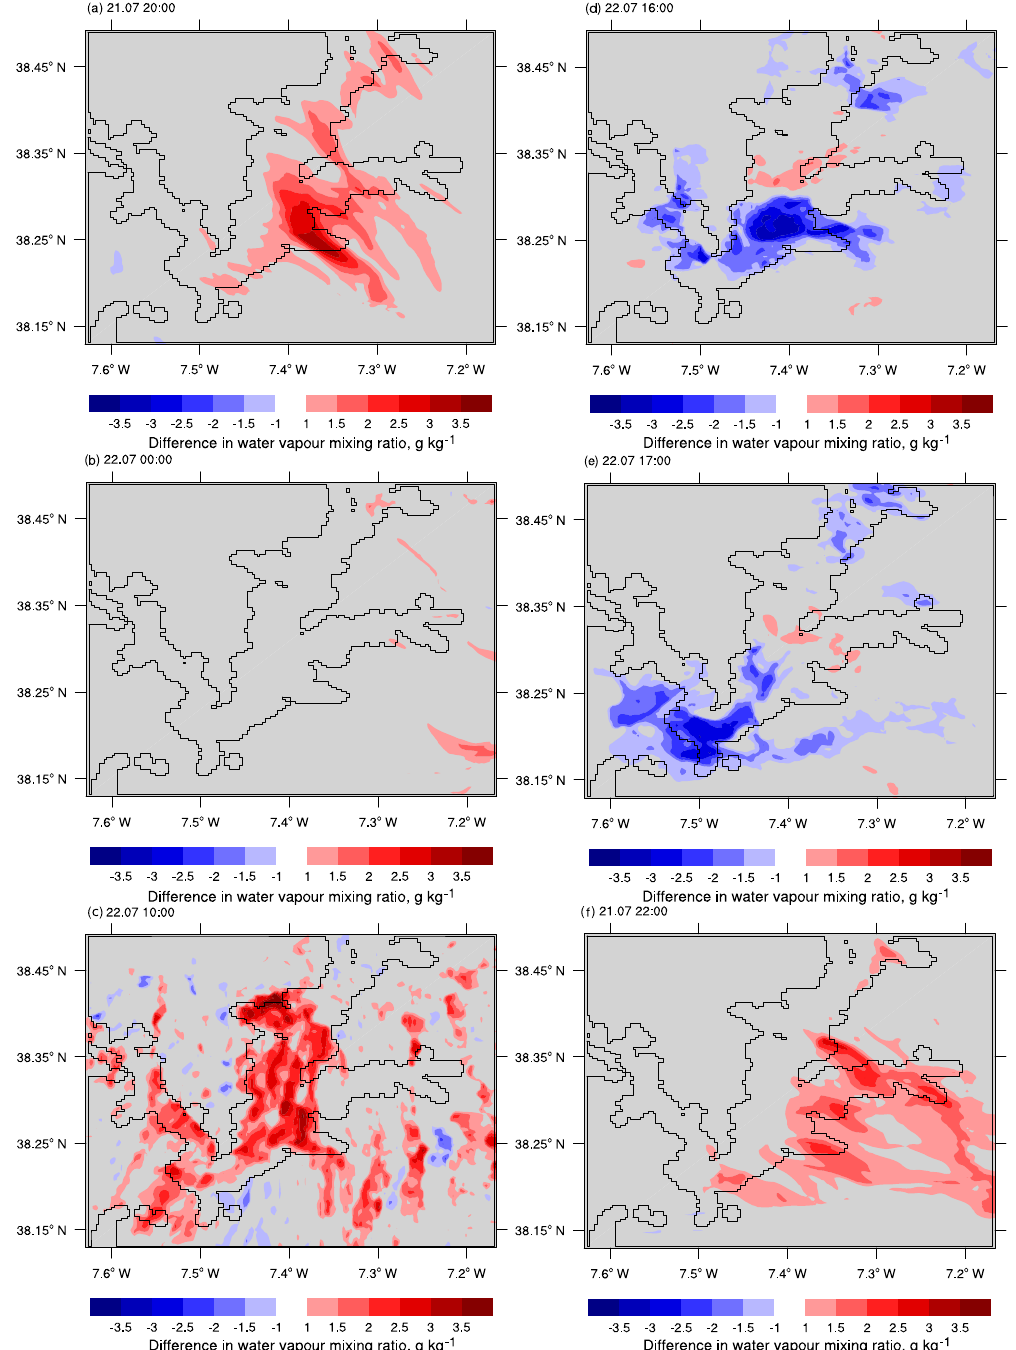
Figure 14. Observed and simulated water vapour mixing ratio anomalies in filled contours on 22 July 2014 in domain C for selected hours.